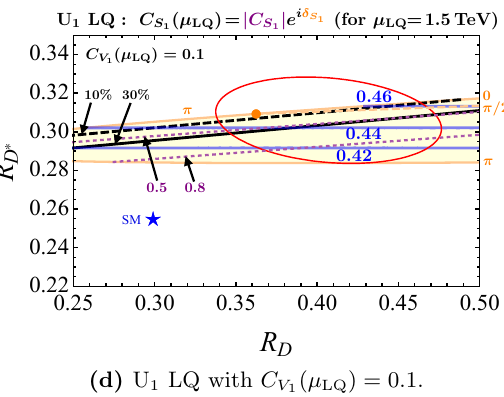
Figure 2. The F D (cid:3) contour is shown on the R D { R D (cid:3) plane with the blue line in (a) R 2 , (b) S 1 L with C V = 0, (c) S 1 with C V = 0 : 1 and (d) U 1 with C V = 0 : 1 LQ scenarios at m LQ = 1 : 5 TeV. 1 1 1 The plot legend is the same as that in (cid:12)gure 1. The orange point stands for the case of C S and C V = 0 : 1 for the S 1 LQ or C S = 0 and C V = 0 : 1 for the U 1 1 1 1